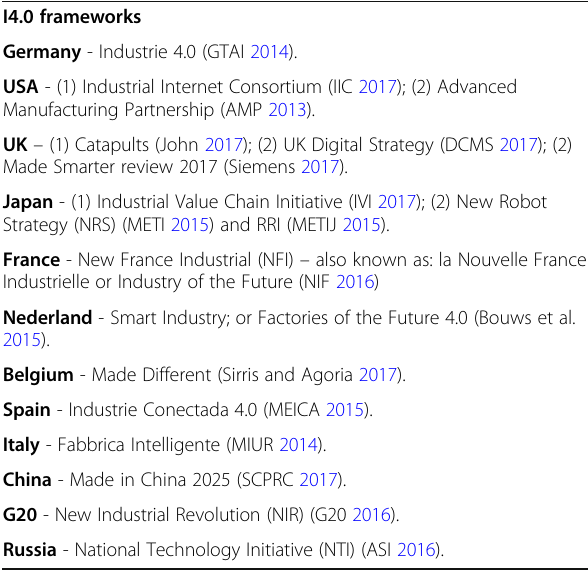
Table 6 I4.0 frameworks